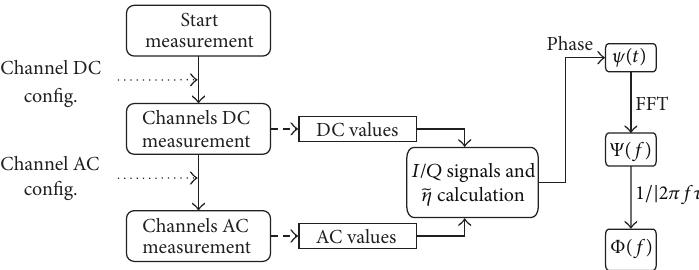
Figure 9: Phase noise power spectral density calculation algorithm.